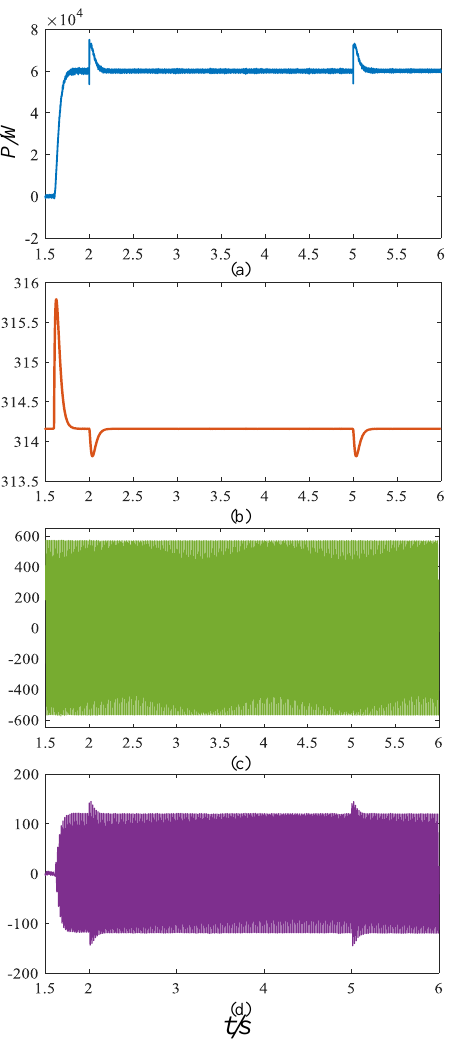
Figure 15. The waveforms of VVSG output active power, angular frequency, line voltage and phase current with power load varies. ( a ) VVSG output active power; ( b ) VVSG output angular frequency; ( c ) VVSG output line voltage; ( d ) VVSG output phase current.